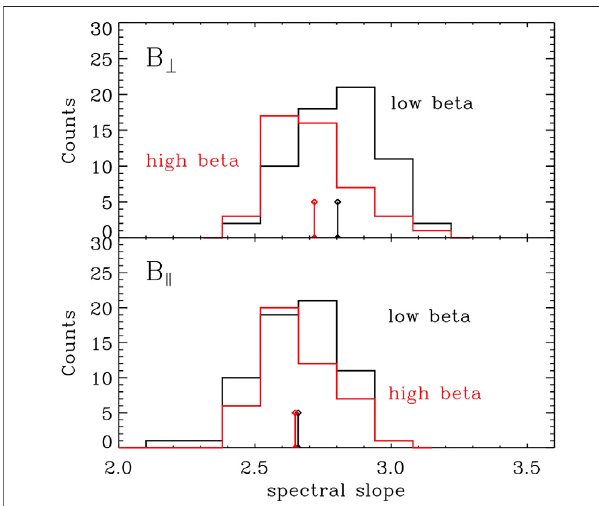
FIGURE 5 | Spectral slope measured for different beta conditions in Cluster data; (black) β < 2 and (red) β > 2. Top panel refers to the spectrum of the perpendicular magnetic component B ⊥ and the bottom panel to B (cid:3) . The short vertical lines ending with a diamond indicate average values of the histograms.